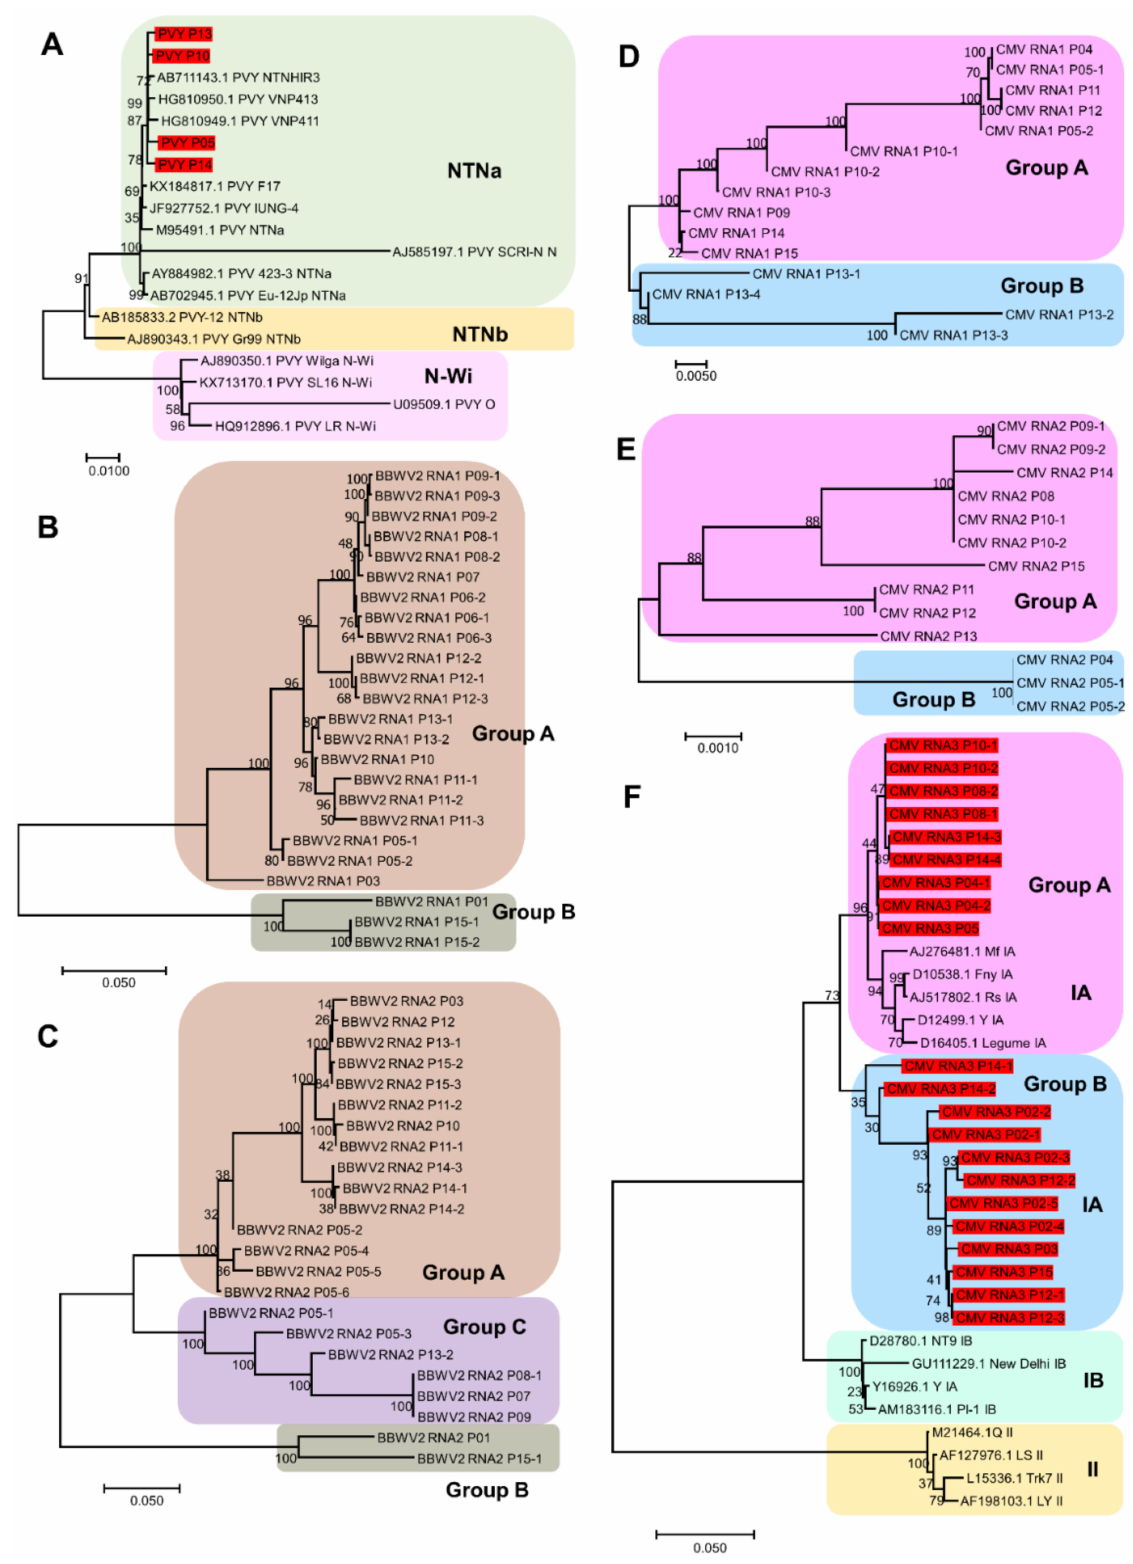
Figure 7. Phylogenetic tree of viruses, PVY, CMV and BBWV2, infecting pepper cultivars: phylo- genetic tree of complete genome sequences of PVY ( A ), BBWV2 RNA1 segment ( B ), BBWV2 RNA2 segment ( C ). CMV RNA1 segment ( D ), CMV RNA2 segment ( E ), CMV RNA3 segment ( F ). The viral genome sequences in ( A , B ) derived from this study were indicated by red-colored